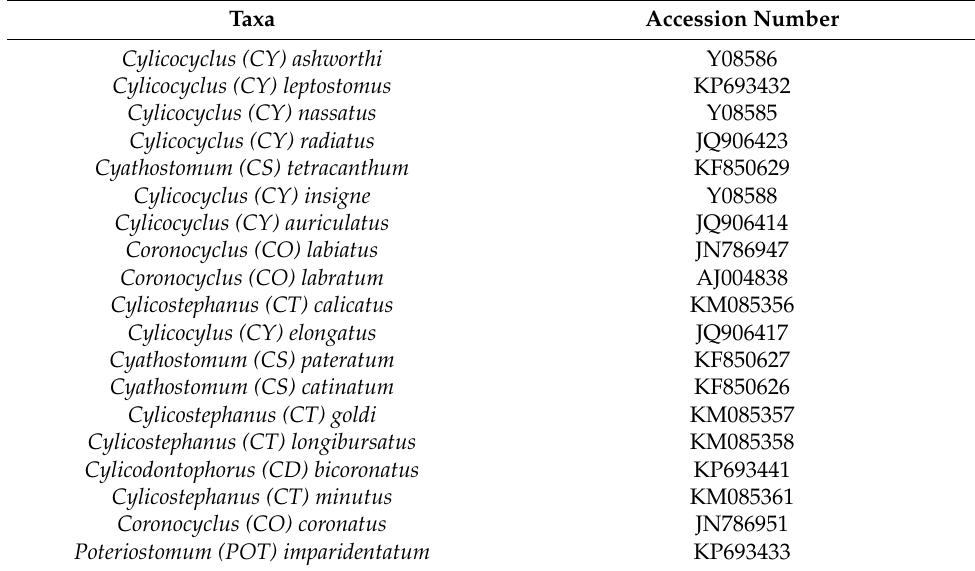
Table 2. Species accession numbers of aligned sequences of cyathostomins for taxonomy